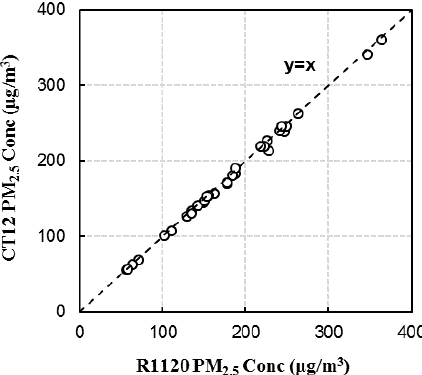
Figure 10. Scatter diagram of the R1120 and CT12 experiments for PM 2 . 5 concentrations. The “ y = x ” line represents that the simu- lated value from R1120 is the same as CT12.